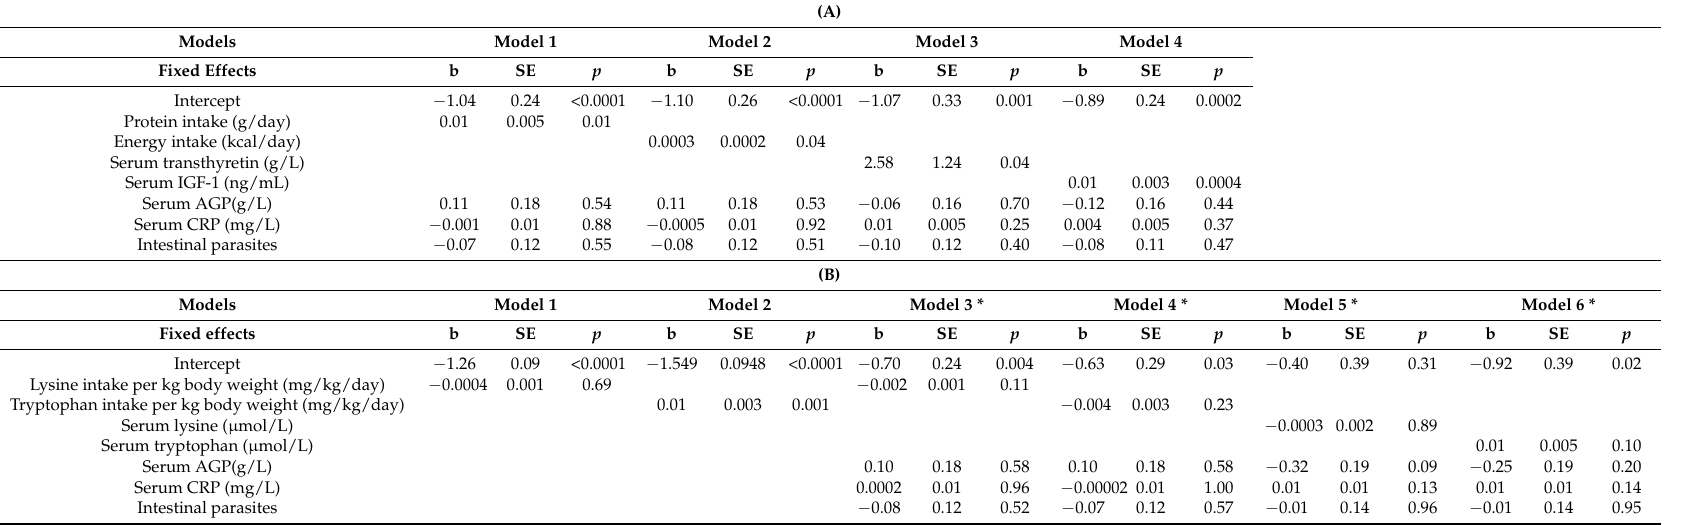
Table 7. ( A ) The relationships of protein and energy intake, serum transthyretin, and serum IGF-1 with the linear growth (height-for-age, HAZ) of children; ( B ) The relationships of lysine and tryptophan intake and serum lysine and tryptophan with linear growth (height-for-age, HAZ) of